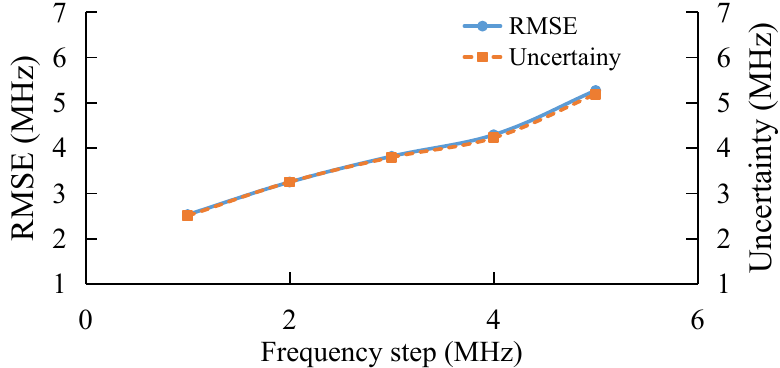
Figure 13. Experimental results under different frequency step.